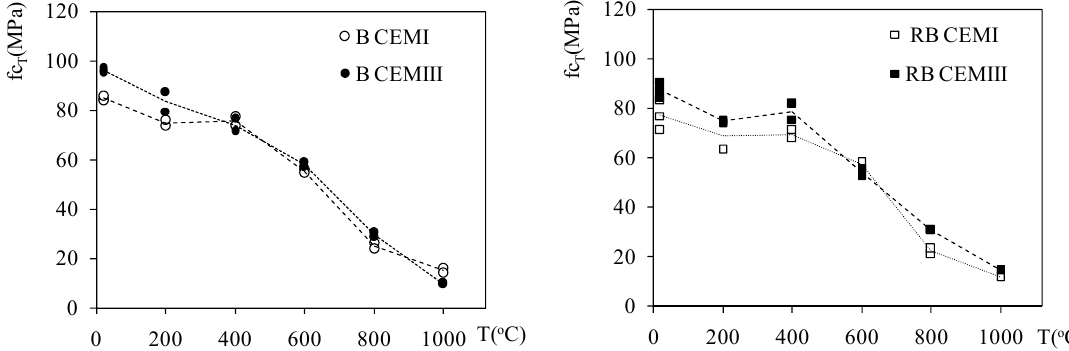
Figure Figure 3. The compressive strength evolution CEMI and CEMIII concretes on basalt and riverbed aggregate.